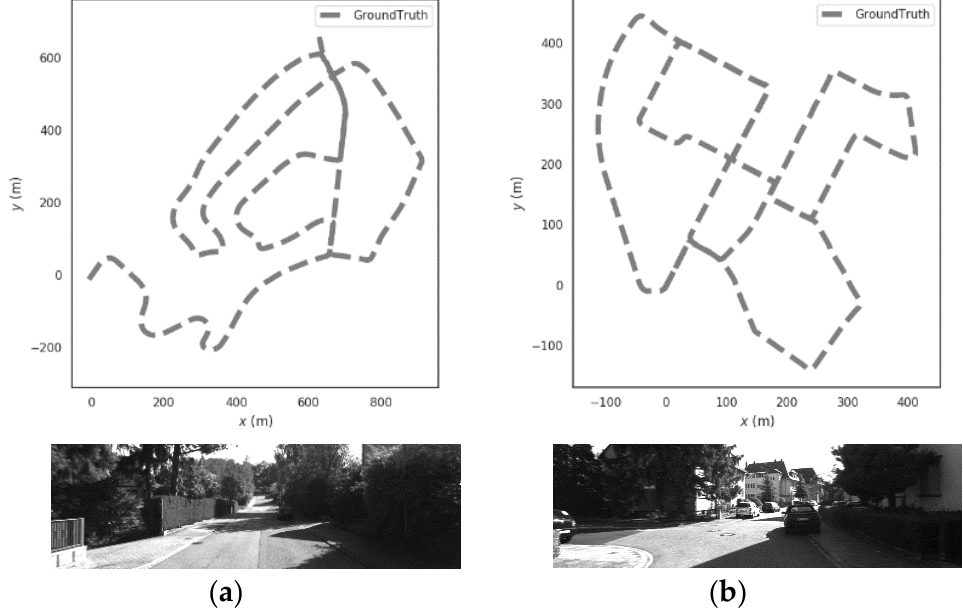
Figure 5. Trajectories of ground-truth in ( a ) rural and ( b ) urban scenes.